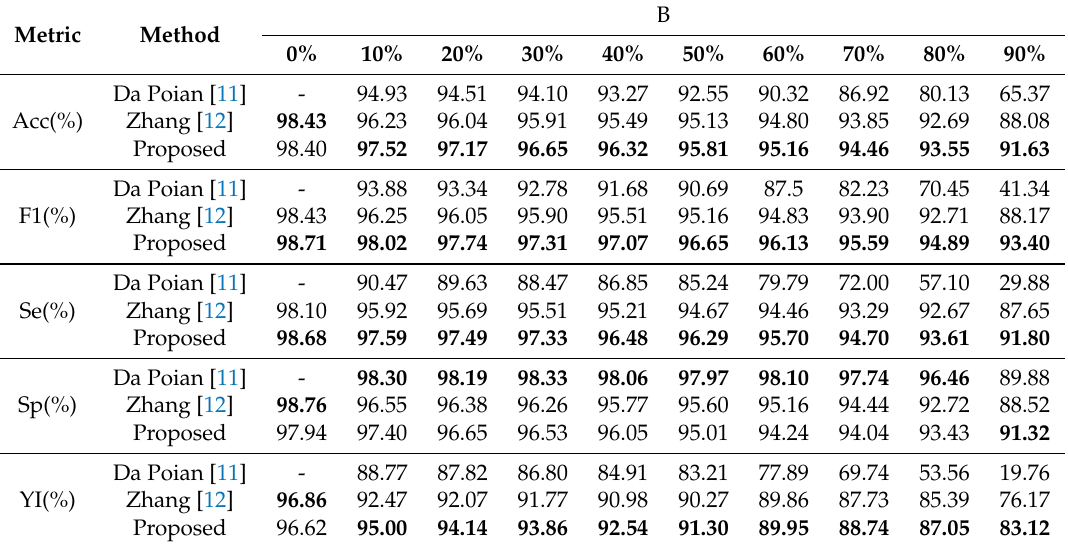
Table 3. Comparison of classification performance between the proposed method and existing methods for AF detection from compressed ECG. Sensitivity (Se) is the probability of no missed diagnosis, while specific (Sp) is the probability of no misdiagnosis. This table shows that the classification performance of the proposed method is superior than the other methods. Bold numbers represent the best results among the compared